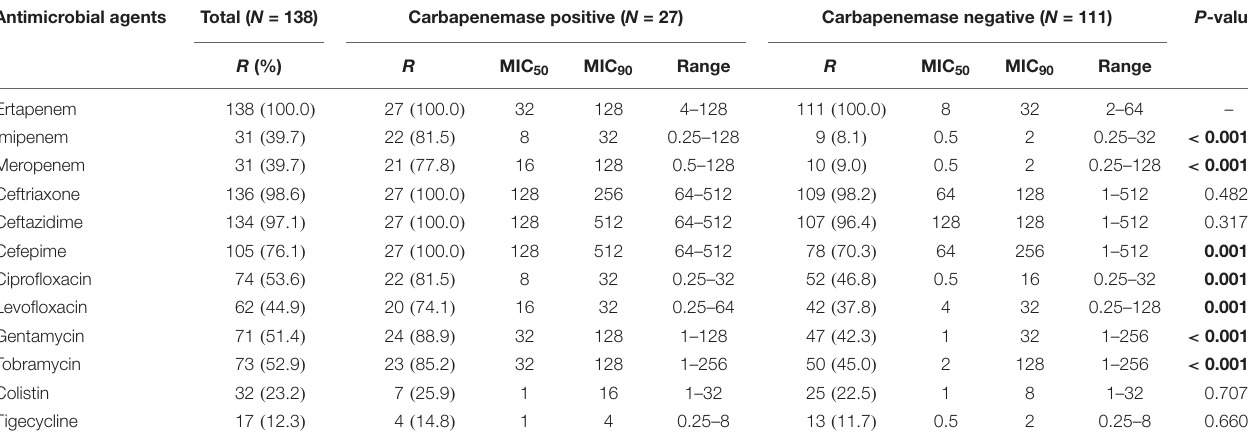
TABLE 1 | Antimicrobial susceptibility of CR-ECL isolates with or without carbapenemase. Antimicrobial agents Total ( N = 138) Carbapenemase positive ( N = 27) Carbapenemase negative ( N = 111)